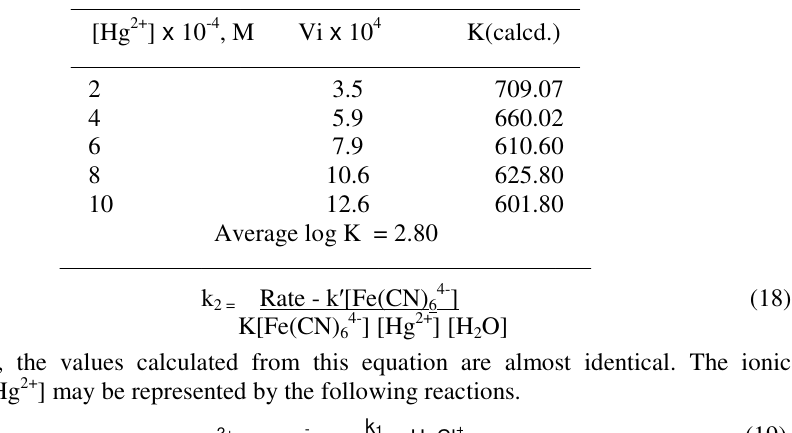
Table 1. Calculation of K by varying [Hg 2+ ] at constant [Fe(CN) 64- ]. [Fe(CN) 64- ] = 8 x 10 -4